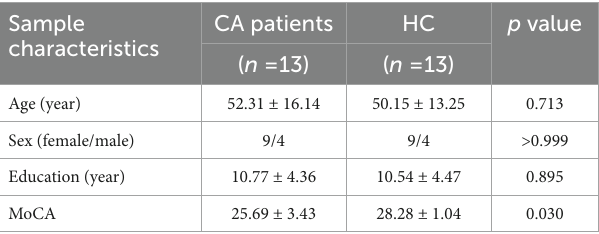
CA, cardiac arrest; ROSC, return of spontaneous circulation; CPC, Cerebral Performance Categories; MRI, magnetic resonance imaging; MoCA, Montreal Cognitive Assessment; CPC, Cerebral Performance Categories; mRS, modified Rankin Scale; GCS, Glasgow Coma Scale; M, male; F, female; AMI, acute myocardial infarction; IHCA, in-hospital cardiac arrest; OHCA, out-of-hospital cardiac arrest. TABLE 2 Comparison of demographic and clinical data between CA and HC group. Sample characteristics